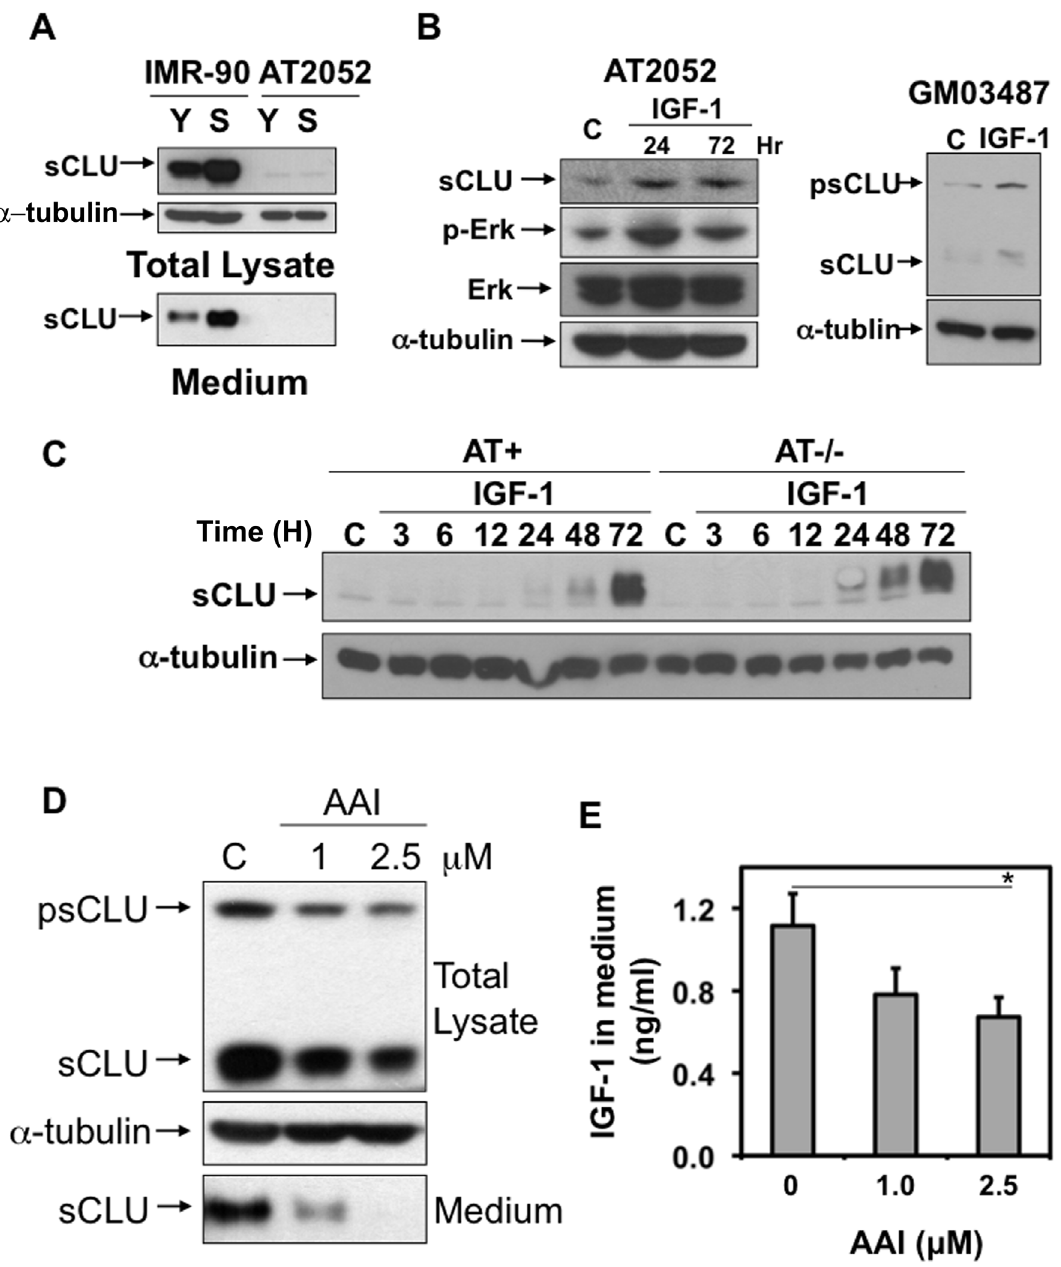
Figure 3. ATM is required for sCLU induction during senescence. (A) ATM-deficient AT cells have extremely low basal sCLU levels, where expression is regulated purely by IGF-1 in the medium [27]. sCLU levels were increased in both total lysates and in the medium from senescent IMR- 90 cells, however, sCLU was not changed during senescence in AT2052 cells. The %SA- b -gal + cells in the population from young IMR-90 cells was , 5%, whereas the percentage of senescent IMR-90 cells was . 60%. The %SA- b -gal + cells in the Young AT2052 cell population was , 20%, whereas the senescent population was . 60% for AT2052 cells. (B) IGF-1 induced sCLU in ATM-deficient, AT fibroblasts. ATM-deficient AT2052 or GM03487 cells were cultured in 0.2% FBS medium overnight, and then treated with IGF-1 (10 ng/ml). Cells were harvested at the indicated times and sCLU as well as total and phospho-Erk-1/2 levels were measured by Western Blotting from total cell lysates. a -Tubulin levels were used for loading. (C) IGF-1 induces sCLU in genetically matched ATM-deficient and -proficient AT cells. Immortalized AT cells (AT 2 / 2 ) and wild type, ATM reconstituted cells (ATM + ) were cultured in 0.2% FBS medium overnight. IGF-1 (10 ng/ml) was then added in both ATM + and ATM 2 / 2 cells. Cells were harvested at indicated times and sCLU and a -tubulin levels were monitored as described above. (D) Inhibition of ATM activity represses sCLU expression in senescent IMR-90 cells. psCLU and sCLU were repressed by the ATM inhibitor, AAI, in both total cell lysates and medium from senescent IMR-90 cells (%SA- b -gal + were . 60%). These cells were pre-cultured in 0.2% FBS medium overnight, then treated with 1.0 or 2.5 m M AAI or exposed to vehicle alone. After treatment (48 h), cells and medium were collected and Western Blot analyses were performed to measure sCLU level. a -Tubulin levels were used to monitor loading. (E) Inhibition of ATM activity repressed IGF-1 expression in senescent IMR-90 cells. IGF-1 levels in the media from cells in (D) were measured using ELISAs as described in ‘Materials and Methods’. Human recombinant IGF-1 was used as standard. Results were normalized to both total volume of medium and total cell number.